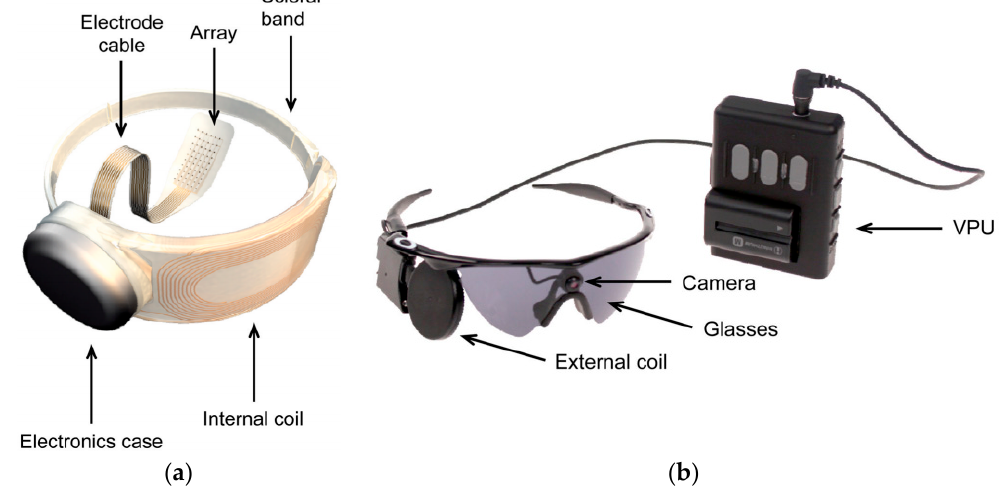
Figure 18. ARGUS II retinal prosthesis system [114]. ( a ) Wearable external parts. ( b ) Illustration of the implanted parts. Copyright © 2018 Second Sight Medical Products, Inc, USA.